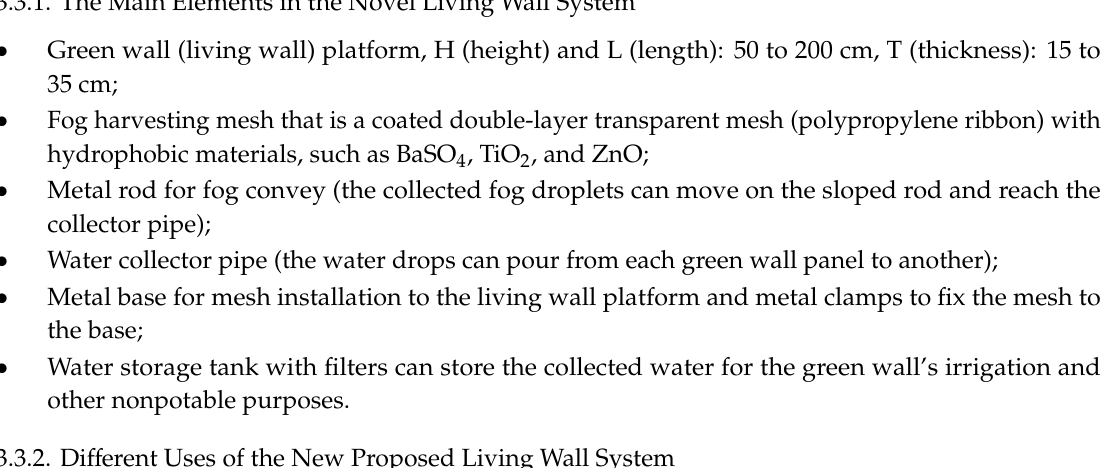
Figure 4. The view of the combined living wall system after installation of all platforms. 12—water storage tank with filters, D1—direction of water droplets to the downside collector pipe, D2—direction of the water droplets on the slopped rods, D3—the way of using harvested water for irrigation or other usages in the buildings.